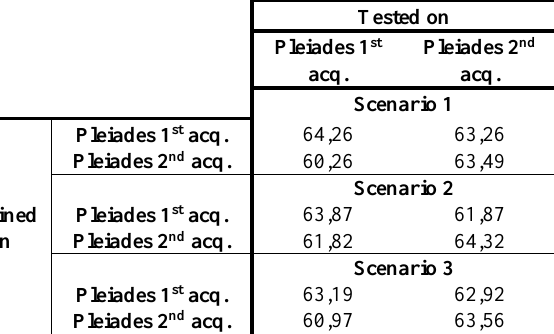
Table 4. F1-score result for the cross-time performance